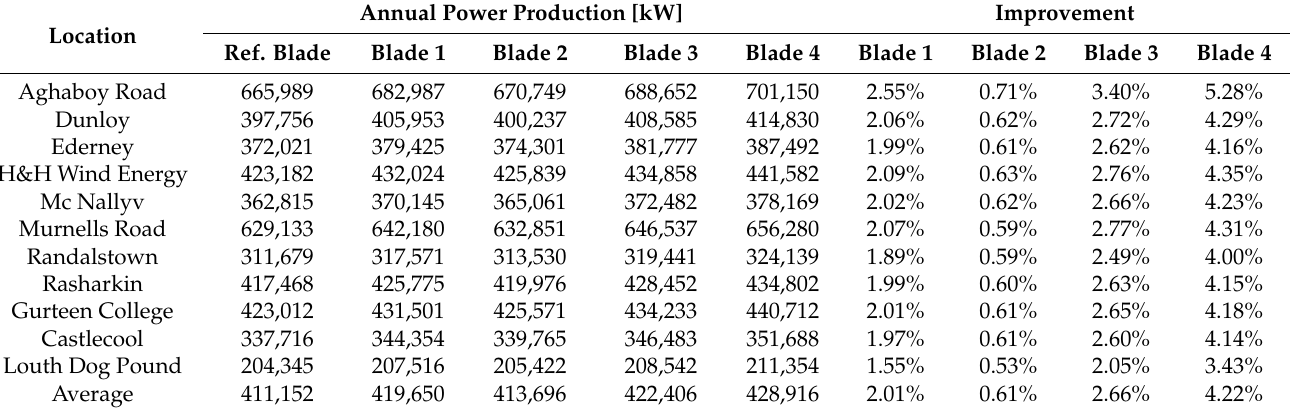
Table 5. Annual power production estimations of the V27 wind turbine with the optimised blades at different locations in Ireland.